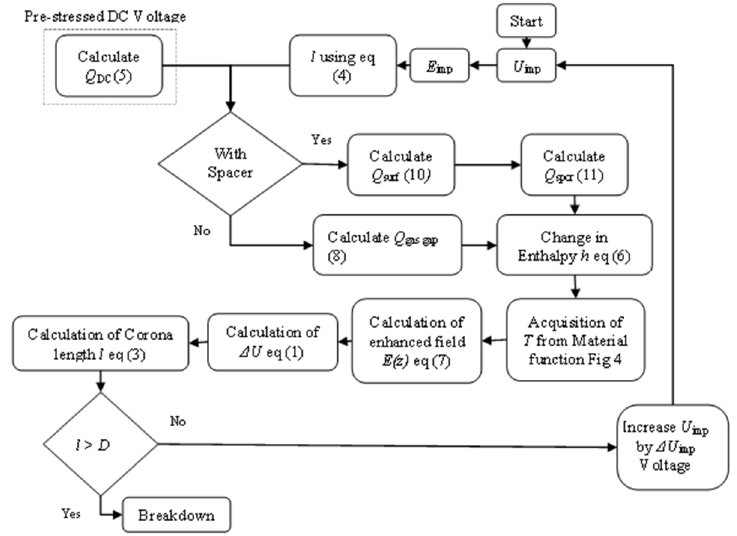
Figure 5. Simulation steps